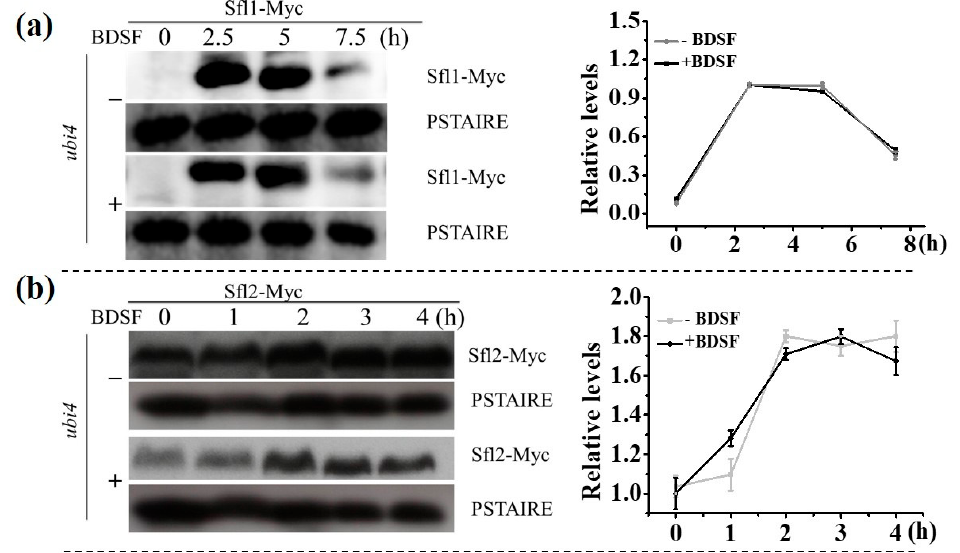
(right panels) were analyzed using ImageJ software. Normalizations were performed against the corresponding protein signal at 0 h ( a , b ) or 1 h ( c ). under hyphal inducing condition, BDSF treatment helps to maintain Ubi4 and Sfl1 proteins at a high level, resulting in rapidly decrease of Sfl2 protein, hence inhibits hyphal morphogenesis.